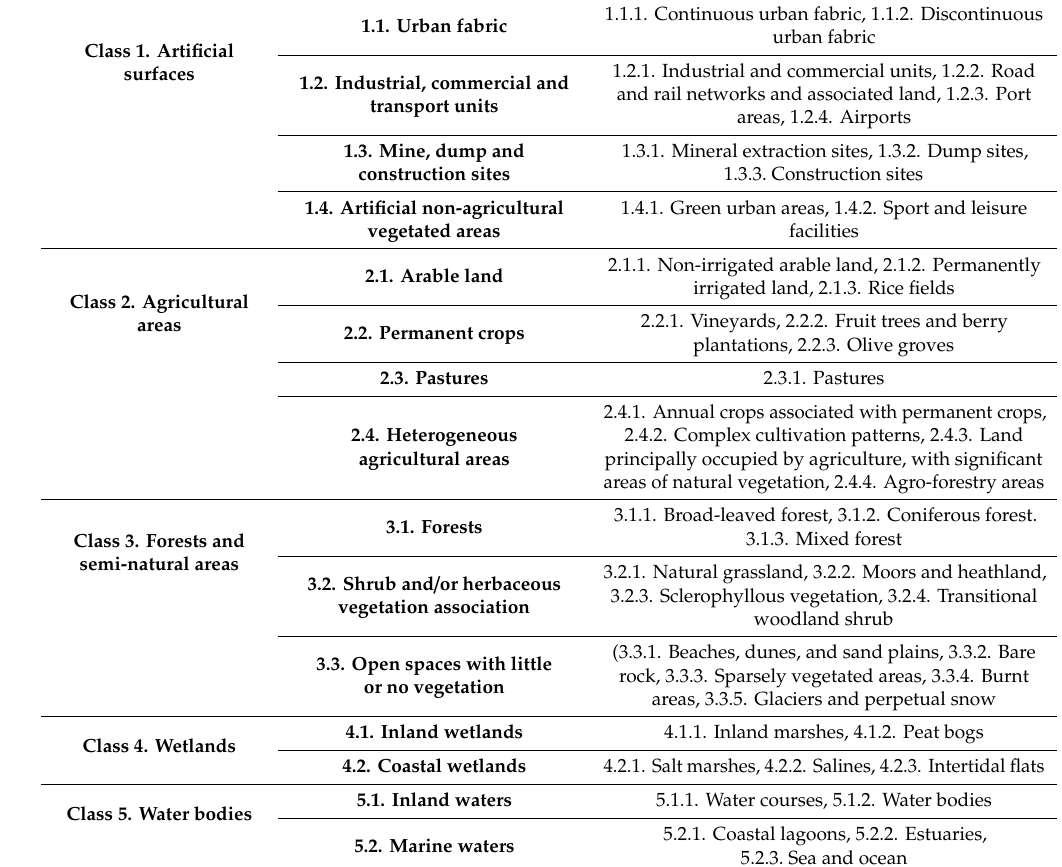
Table 1. Land cover categories according to Corine Land Cover